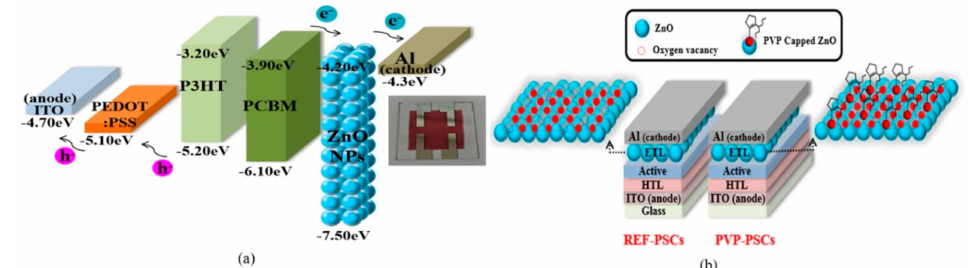
Figure 1. Schematic diagram of fabricated bulk-heterojunction (BHJ) polymer solar cells (PSCs). ( a ) Energy band diagram. ( b ) Structure and films state of uncapped-ZnO nanoparticles (NPs) and polyvinyl pyrrolidone (PVP)-capped ZnO